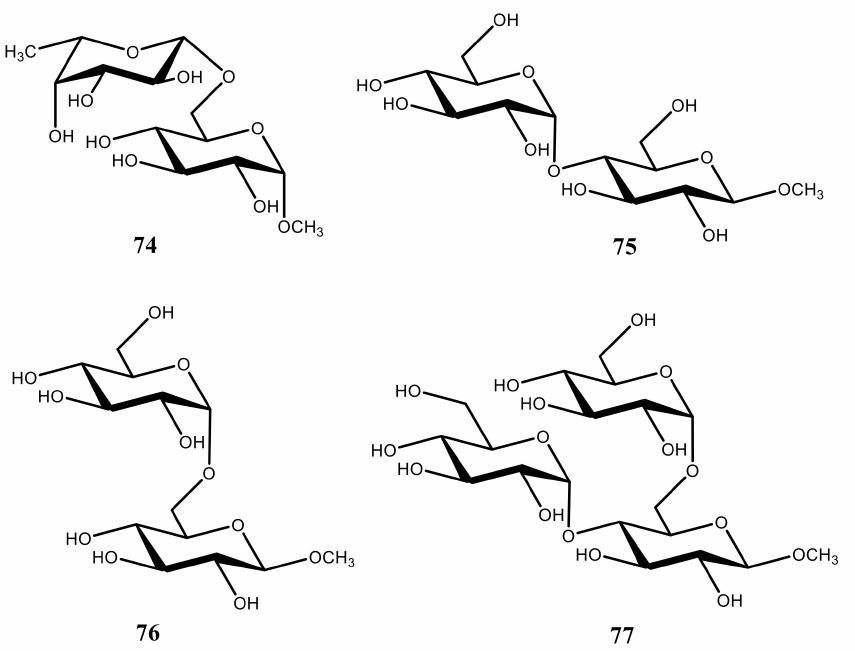
Figure 39. Chemical structures of the representative disaccharides 74 – 76 and trisaccharide 77 provid- ing a preference for the gauche orientation between O 6 and C 5 .